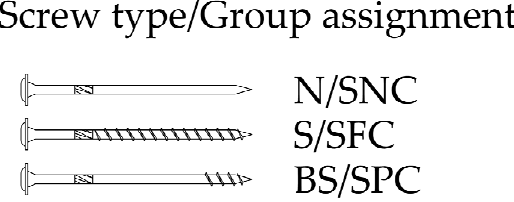
Figure 5. Screw types and corresponding group assignment. Table 2. Summary of groups in the connection tensile test.